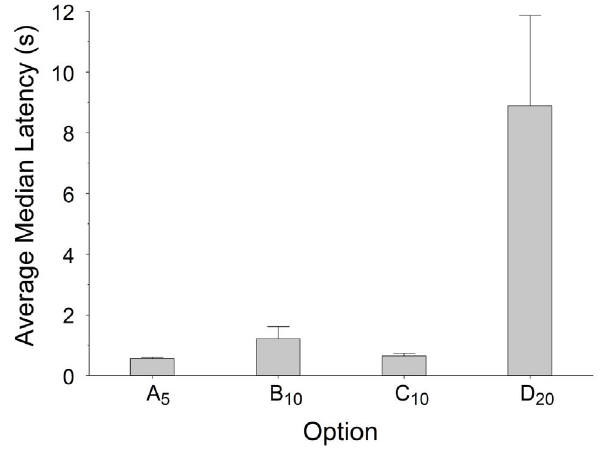
Figure 6. Latencies to accept each option in single-option trials. Median latencies to accept options A 5 , B 10 , C 10 and D 20 in single- option trials, averaged across subjects ( + SE).